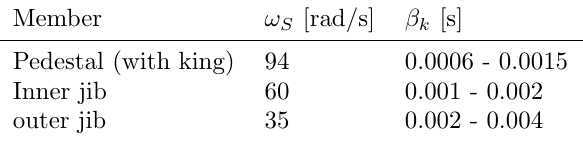
Table 3: Natural frequencies and stiffness